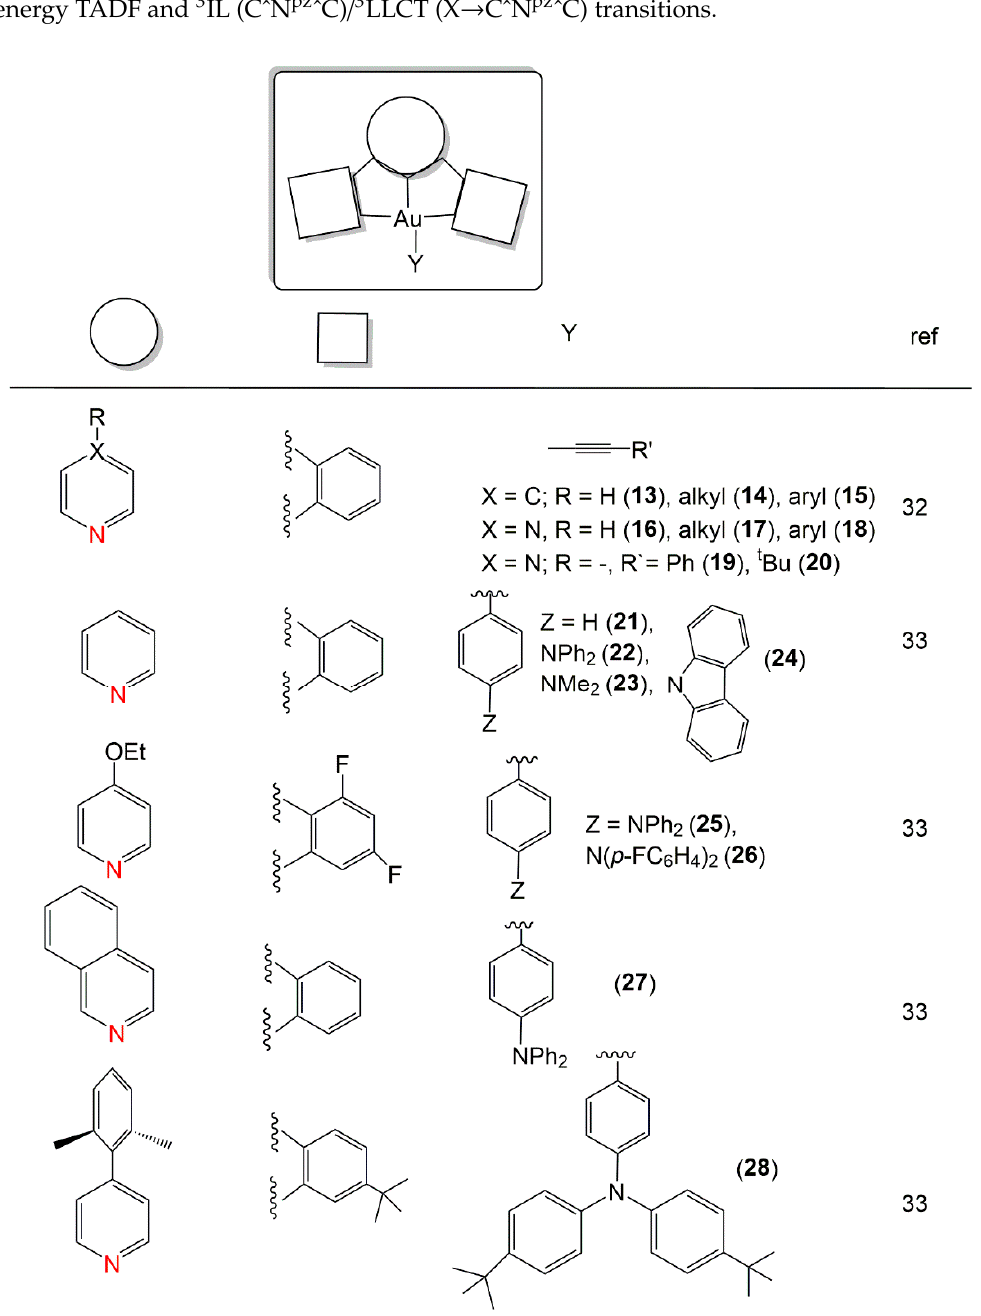
Figure 7. Chemical structure of Au(III) complexes that display TADF properties. Coordinating atoms are marked in red.